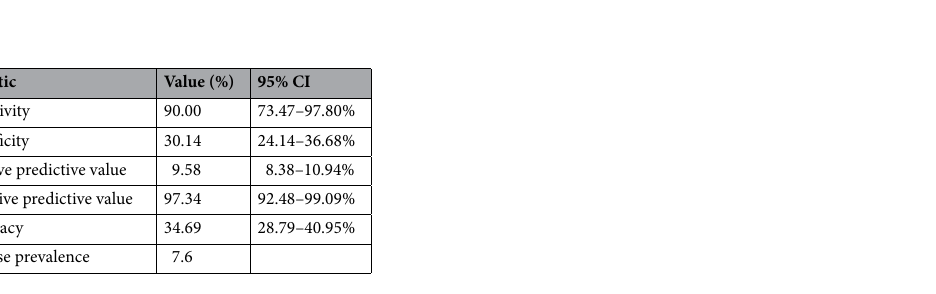
Table 4. Sensitivity, specificity, positive and negative predictive values for the D-dimer test in the inpatient setting.